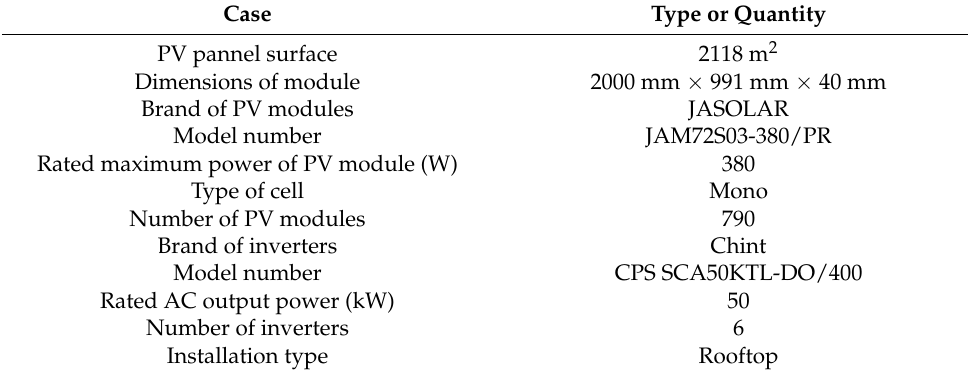
Figure 9. Connection diagram between the panels and the inverters. Table 4. Equipment sizing